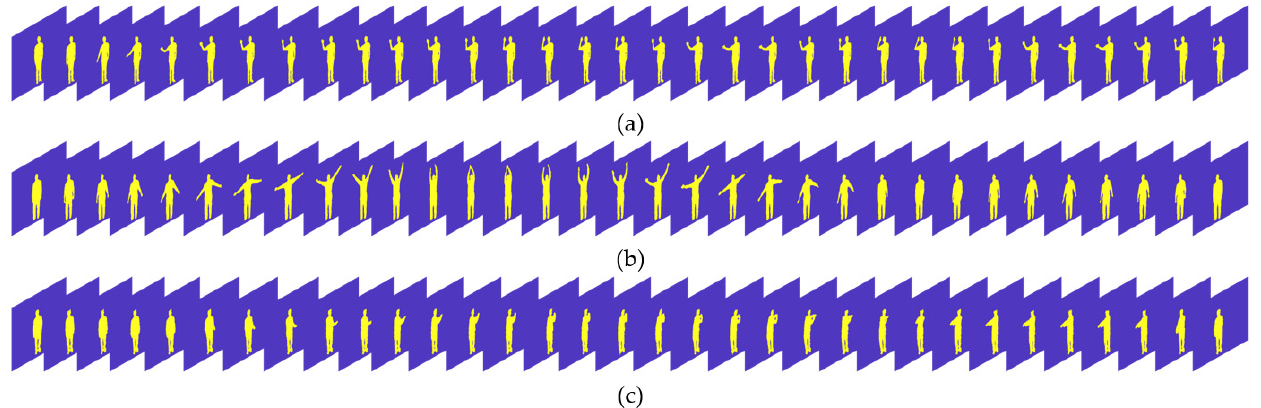
Figure 7. Example of actions in three datasets; ( a ) OneHandWave in the DHA dataset, ( b ) TwoHand- Wave in the MSR-Action3D dataset, and ( c ) BaseballSwing in the UTD-MHAD